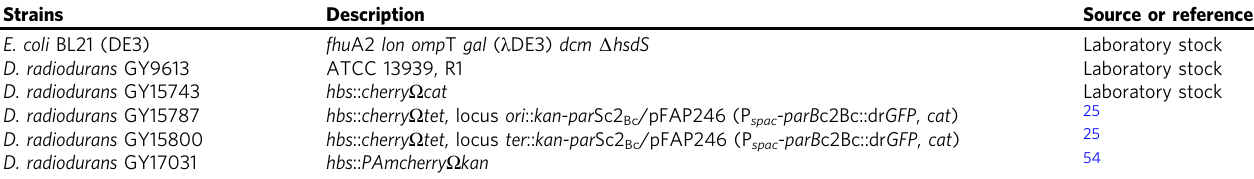
Table 1 Description of bacterial strains used in this study